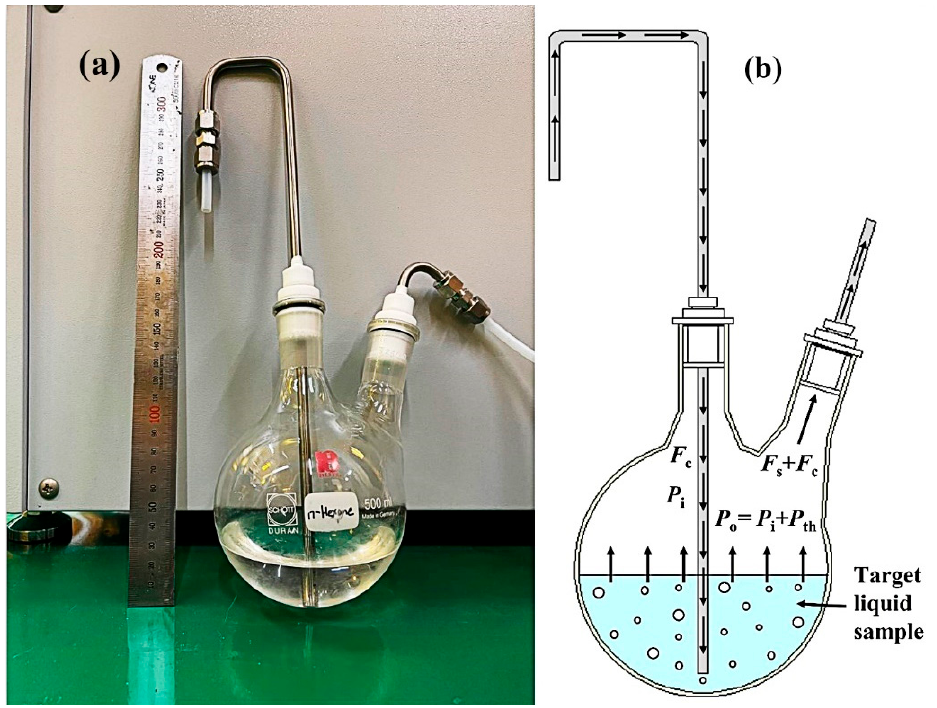
Figure 2. Vaporization system. ( a ) Bubbler flask used in the presented study. ( b ) Schematic diagram of the vapor generating process in the bubbler.